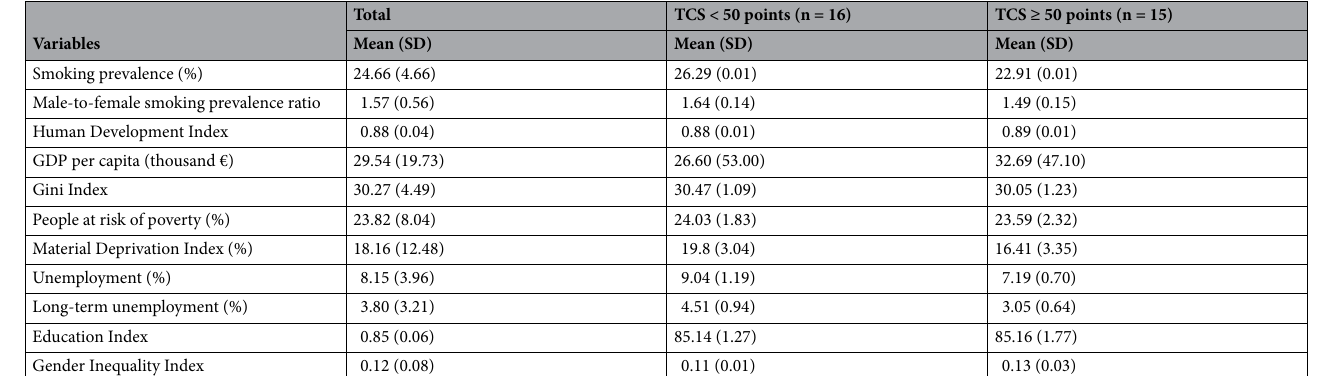
Table 2. Summary of the age- and sex-standardized smoking prevalence, the male-to-female smoking prevalence ratio, and the socioeconomic (SES) indicators of 31 European countries (total and according to their TCS total score) in 2016. SD: Standard deviation; GDP: Gross Domestic Product. TCS total scores were categorized into two categories using the median value (P50 = 49) as cutting point.